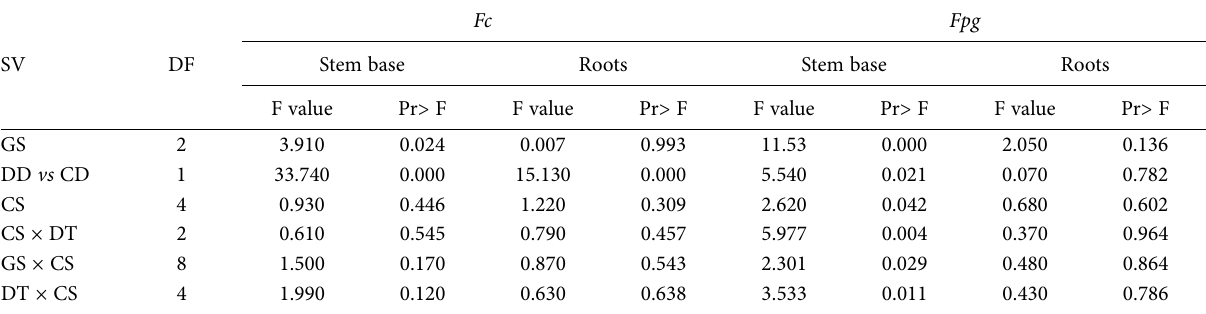
Table 4. ANOVA of the effects of growing season (GS), sowing method (DD vs CD) and crop sequences (CS) on incidence of Fusarium cul- morum ( Fc ) or F. pseudograminearum ( Fpg) infections of durum wheat, oat or barley stem bases and roots during the experimental period. Fc SV DF